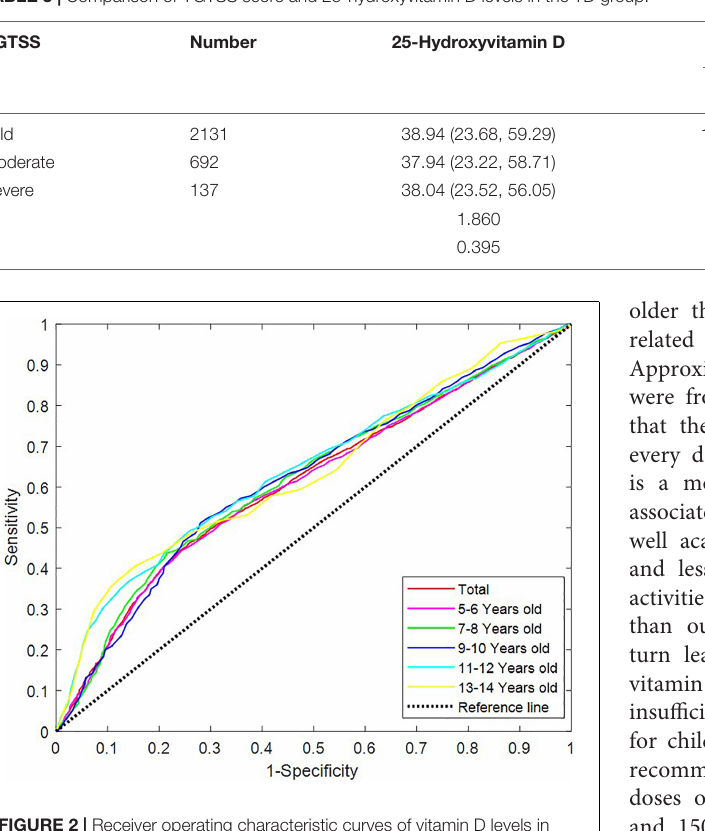
FIGURE 2 | Receiver operating characteristic curves of vitamin D levels in different age groups. ROC, receiver operating